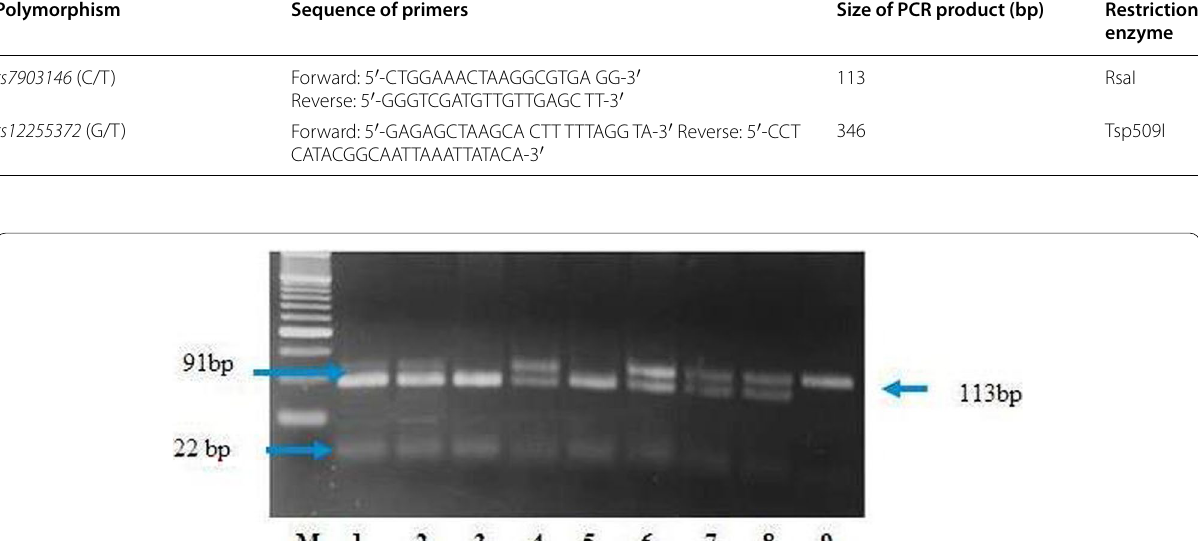
Table 1 Sequence of primers, size of the PCR products, and restriction enzyme used in genotyping of the rs7903146 and rs12255372 in the TCF7L2 gene Polymorphism